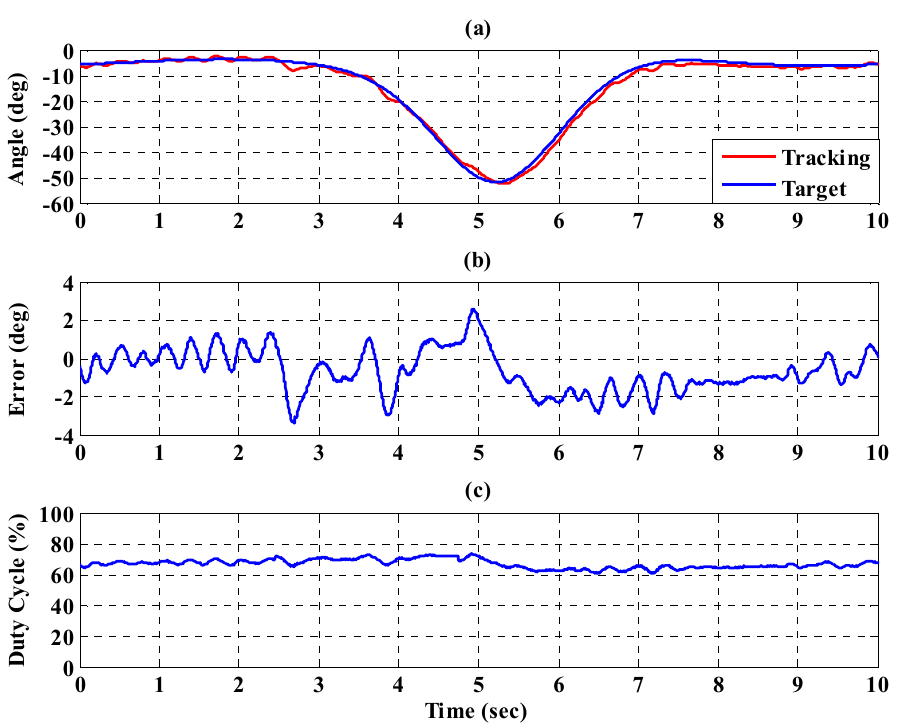
Figure 28. Tracking response of the interval type-2 fuzzy sliding pulse-width modulation controller on the left hip for the PGOS. ( a ) Output response; ( b ) tracking error; ( c ) pulse-width modulation control signal.